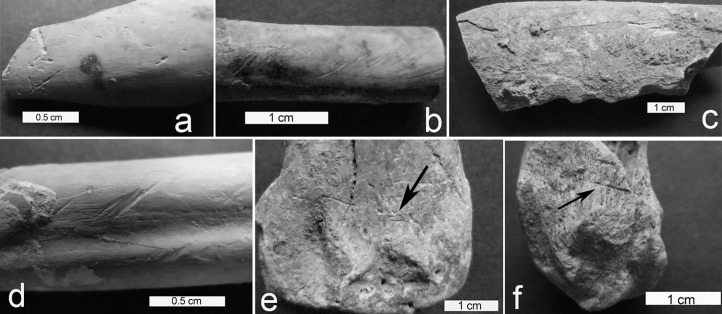
Bone surface modifications in Kuumbi Cave Trench 10.Examples of bone surface modifications in the Trench 10 assemblage: a, biochemical pitting from soil or root bacteria; b, shallow, parallel oblique lines indicating sedimentary abrasion; c, micro-notches along the breakage plane, likely produced by a carnivore; d, overlapping cut marks and abrasion on limb bone of duiker; e-f, cut marks on limb bones of reedbuck and bushbuck, respectively.